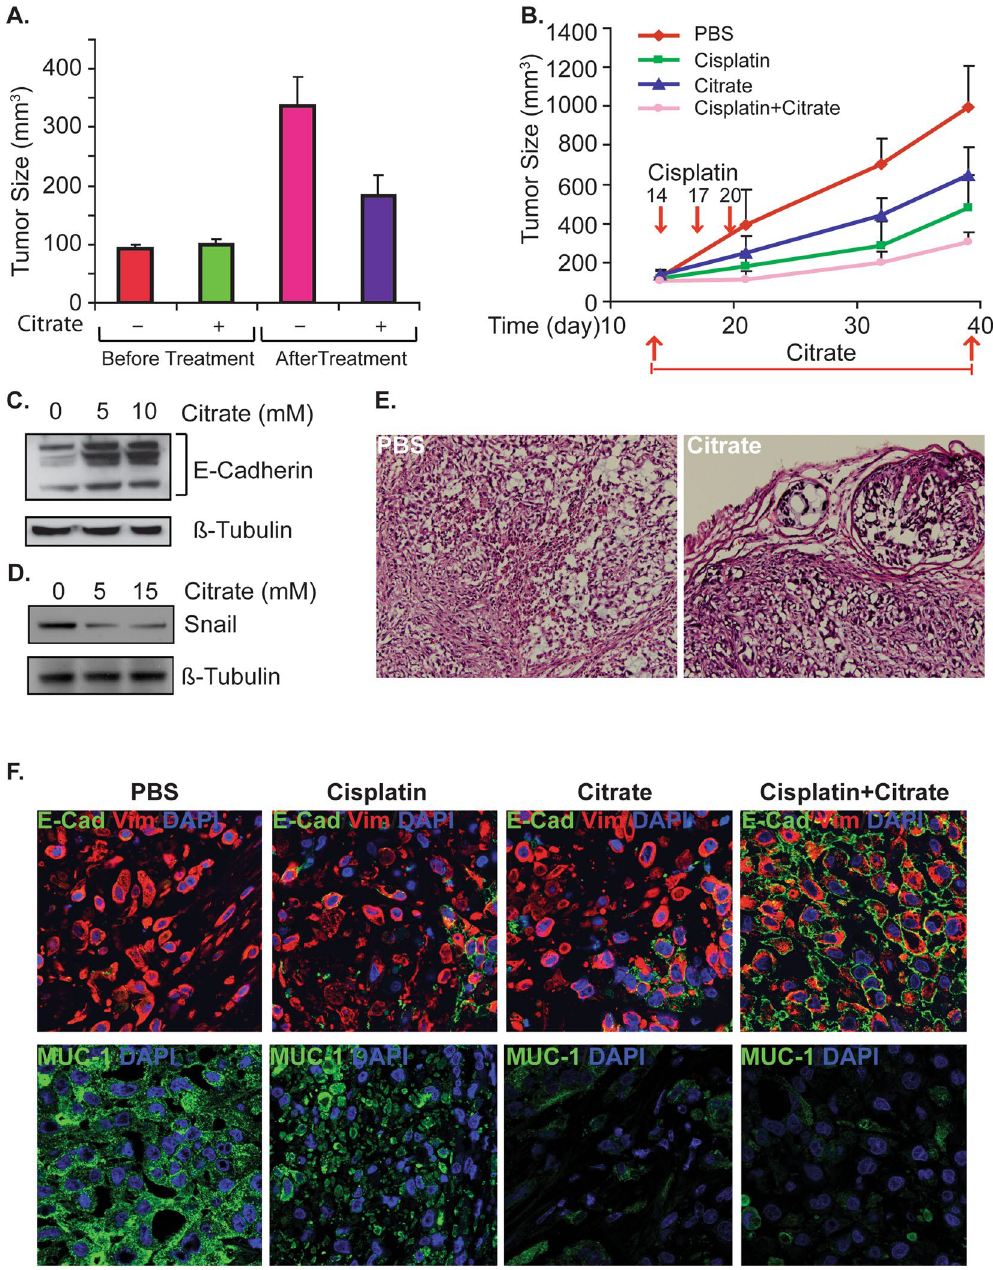
Figure 1. Citrate suppresses tumor growth in vivo . The effects of citrate on tumor growth were examined in xenograft and genetic tumor models. ( A ) 5 × 10 6 A549 cells were injected into nude mice. When the tumor volume reached about 100 mm 3 , mice were given 4 g/kg citrate twice a day for 4 weeks, and tumor-bearing mice were sacrificed after 6 weeks. ( B ) A549 xenograft tumors were treated with citrate (twice daily from day 14 to 40), cisplatin or citrate/cisplatin combination (3 doses of cisplatin at 4 mg/kg on days 14, 17 and 20 were given by i.p.). Tumor volume was calculated using the formula: V = 0.4 AB 2 ( A : long diameter; B : short diameter). ( C ) A549 cells were treated with citrate for 72 h and cell lysate was analyzed by western blot with E-Cadherin and β -tubulin antibodies. The full-length blots are presented in Supplemental Figure S11. ( D ) A549 cells were treated with citrate for 72 h and cell lysate was analyzed by western blot with Snail and β -tubulin antibodies. The full-length blots are presented in Supplemental Figure S12. ( E ) Citrate treatment induces A549 xenograft tumor differentiation (tumor sections from experiment in panel A). F. 5 × 10 6 A549 cells were injected into nude mice. Tumor-bearing mice were sacrificed after 6 weeks of treatment and the tumors were dissected and fixed with 4% PBS-balanced PFA and samples were embedded with OCT. E-cadherin and Muc-1 expression was assessed following standard immunofluorescence protocol. DAPI counter staining shows cell